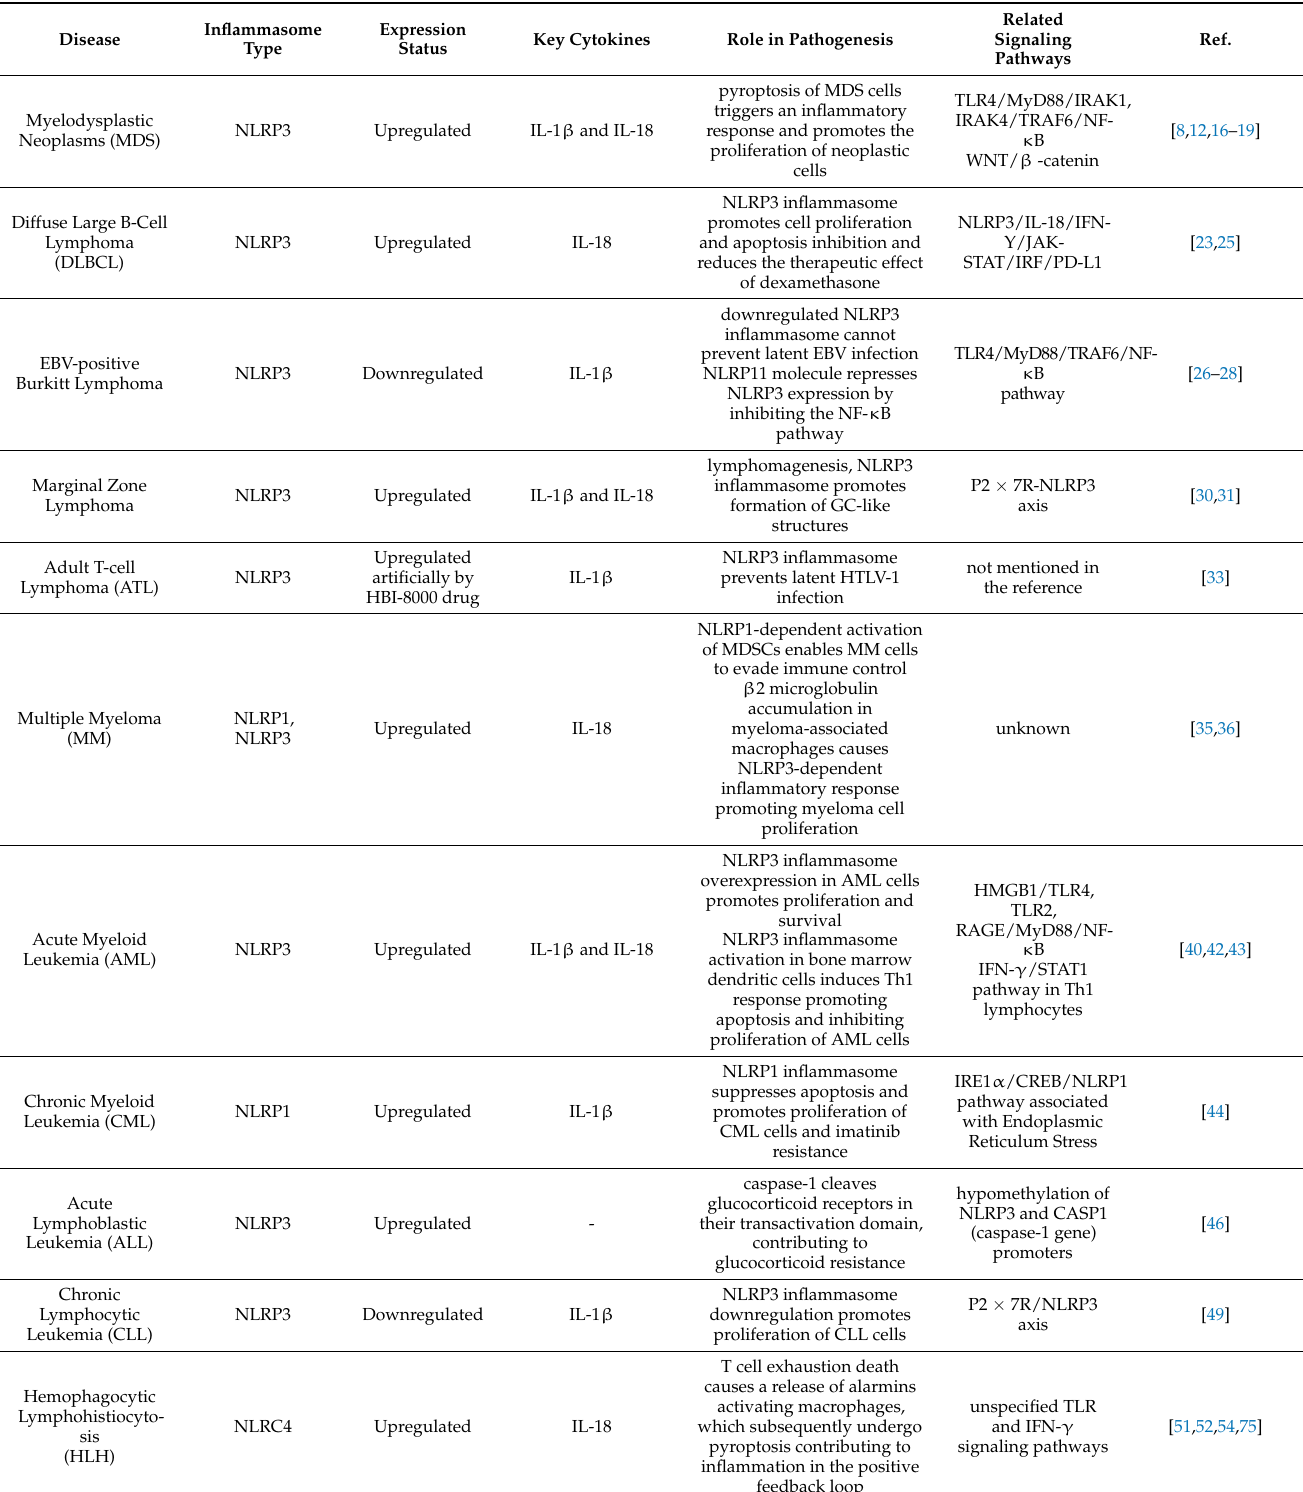
Table 1. The summary of the state-of-the-art in inflammasome-aimed research in hematological dis-